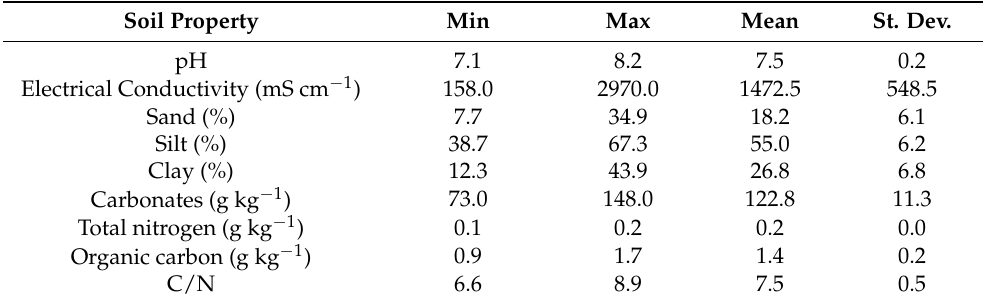
Table 1. Summary of soil property statistics of the study site (Grosseto, Central